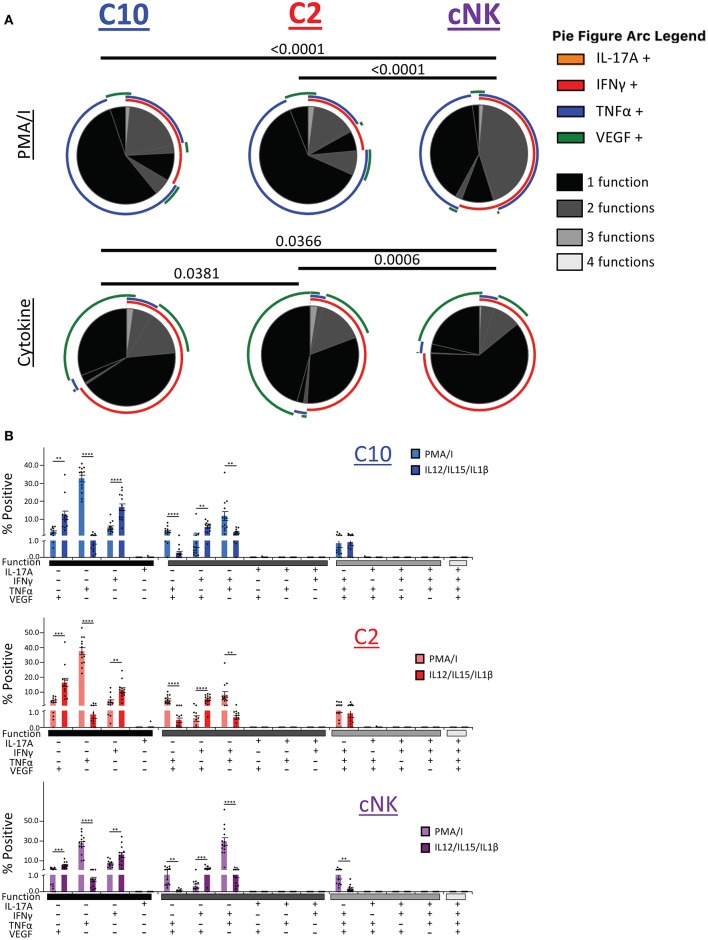
Polyfunctional properties of Novel ILCs. Novel ILCs C10 and C2 display unique polyfunction properties upon PMA/Ionomycin or cytokine (IL-12/IL-15/IL-1β) activation. (A) Pie charts show the proportion of functions that C10, C2, and cNK display after activation with PMA/Ionomycin (top) and cytokines (bottom). Arcs indicate the proportion that produce indicated factor IL-17A, INFγ, TNFα, VEGF. (B) Proportion of positive cells for given combinations of assessed factors after PMA/Ionomyin or cytokine activation. n = 13. Data represented as mean ± SEM. Statistical significance was determined by Student's t-test. **p < 0.005, ***p < 0.0005, ****p < 0.00001. For statistical details see Supplementary Table 12. Data is provided in Data Sheet 1.